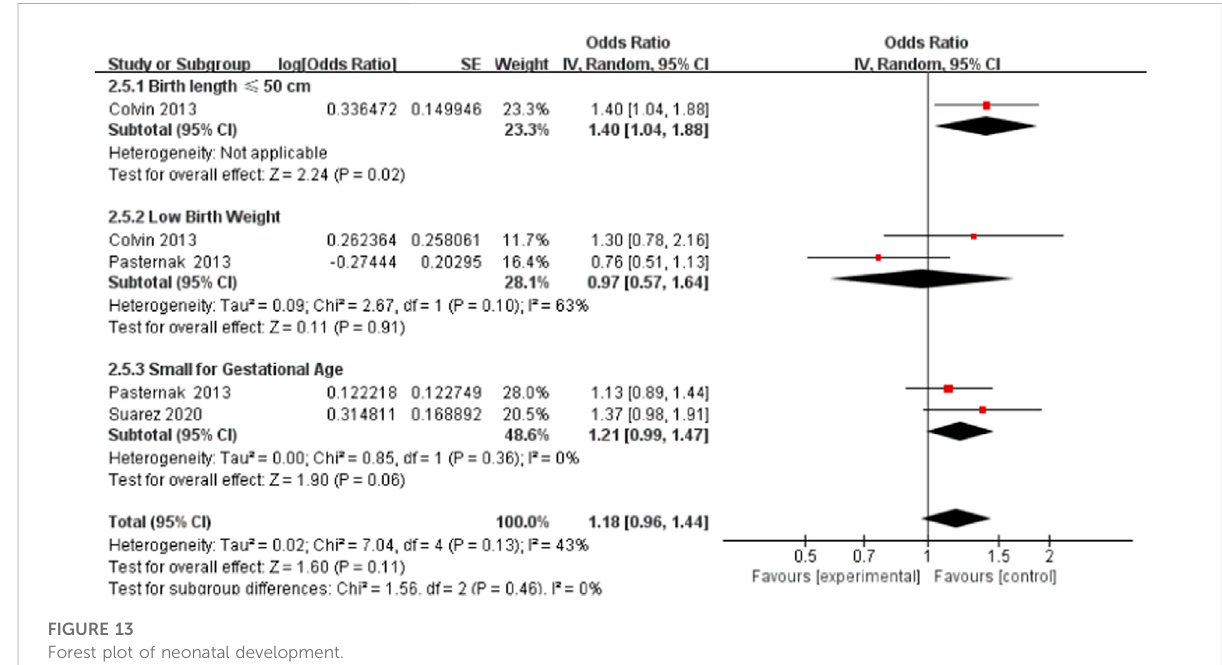
FIGURE 13 Forest plot of neonatal